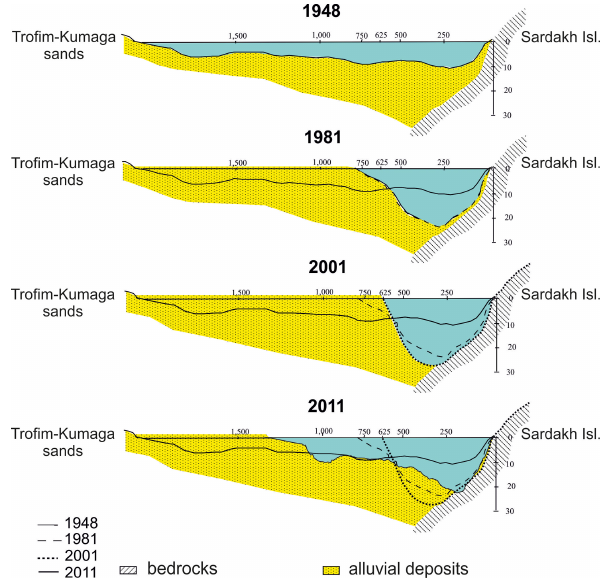
Figure 7. River-bed deformation changes of the Trofimovskaya branch at the Sardakh-Khaya–Trofim-Kumaga cross-section near Sardakh Island for the years 1948, 1981, 2001, and 2011 (33-, 20- , and 10-year intervals, respectively). The x -axis shows distance (m) from Sardakh Island; the y -axis shows depth (m) of the Trofi- movskaya branch.